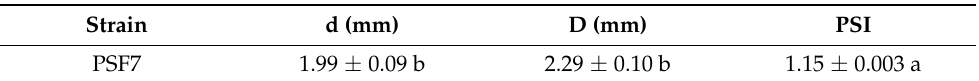
Table 2. Measurement of phosphate-solubilizing capacity of the strain using the transparency circle method.